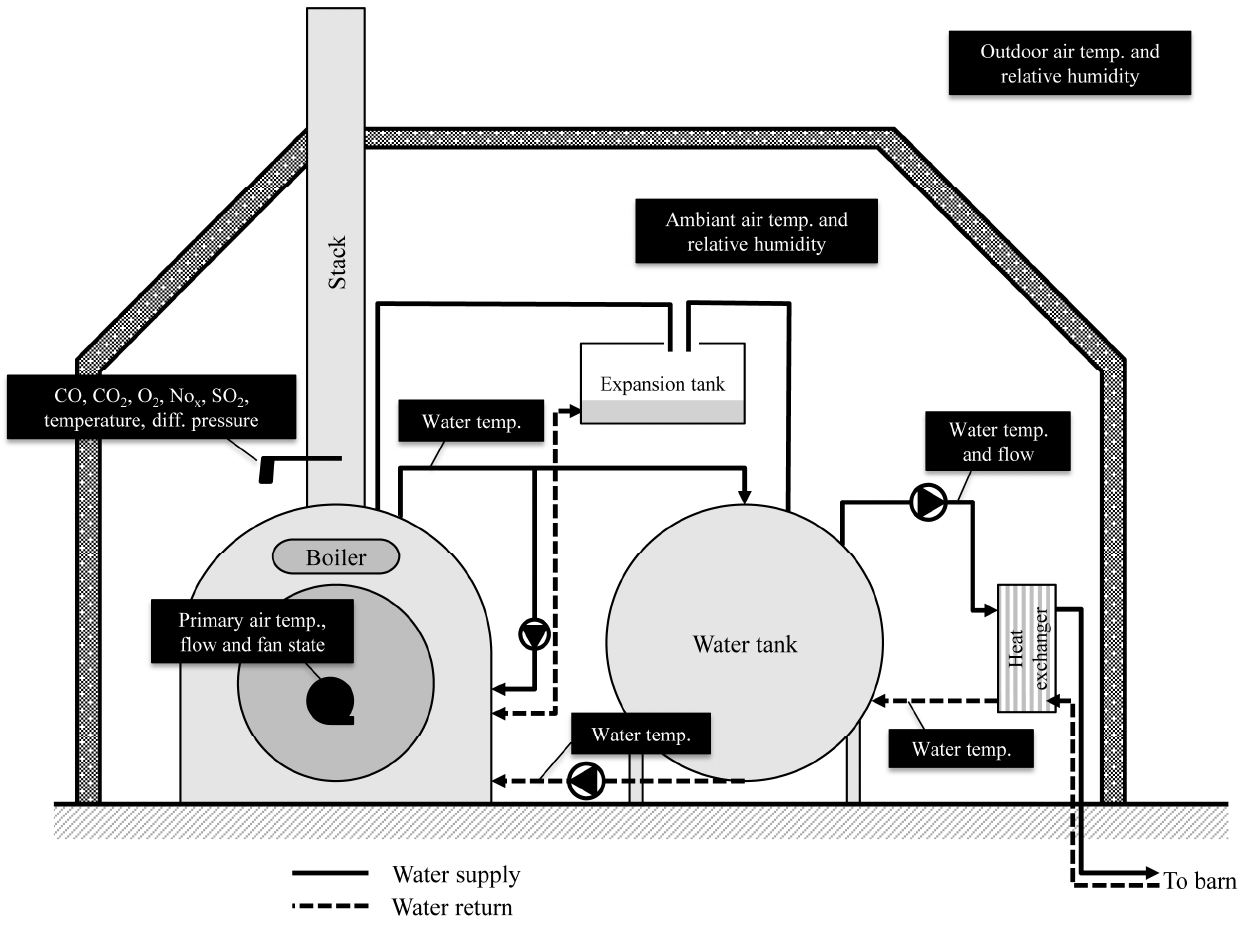
Figure 2. Schematic of the heating system (boiler room), probe location and